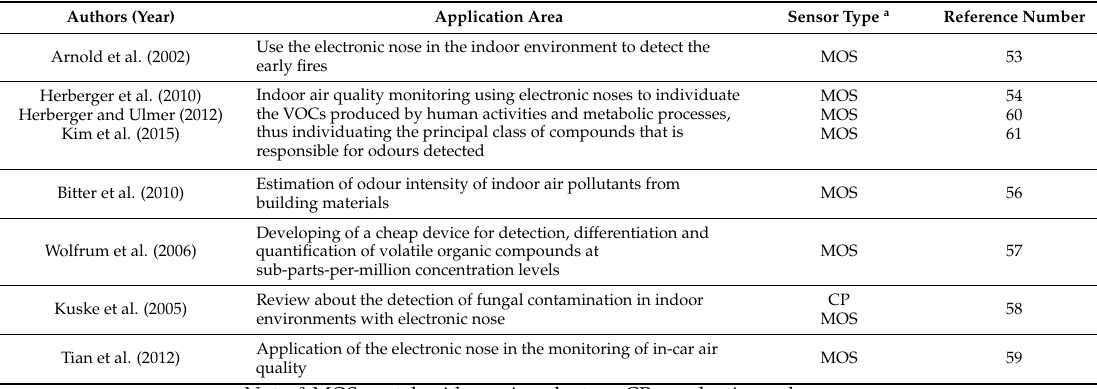
Table 1. International studies focused on the use of e-noses for indoor air quality